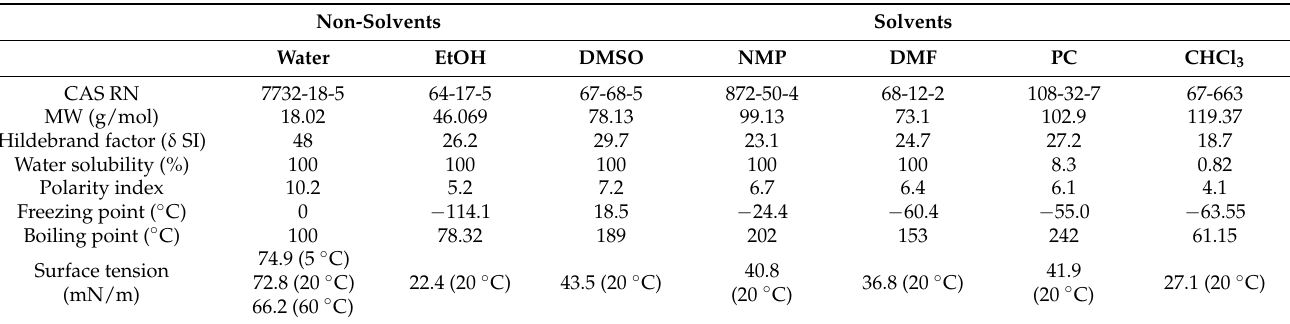
Figure 1. One-step porous membrane-based scaffold formation by air–water interfacial phase separation. ( A ) PTMC-dMA in a solvent is added dropwise to water. ( B ) The PTMC-dMA spreads on the surface of the water over time. An optional N 2 top flow (see arrows) can be applied to enhance the pore gradient. ( C ) The PTMC-dMA floating layer is photo-crosslinked while on the water. ( D ) The scaffold is taken from the water, and the sol fraction is removed by swelling in propylene carbonate (PC), followed by extraction with EtOH. ( E ) Photographs of the air side (top) and water side (bottom) of the scaffold. Scale bars are 1 cm. Table 1. Solvent characteristics. Water and ethanol (EtOH) are non-solvents for PTMC, whereas dimethyl sulfoxide (DMSO), N-Methyl-2-pyrrolidone (NMP), dimethylformamide (DMF) and propylene carbonate (PC) are solvents for PTMC.